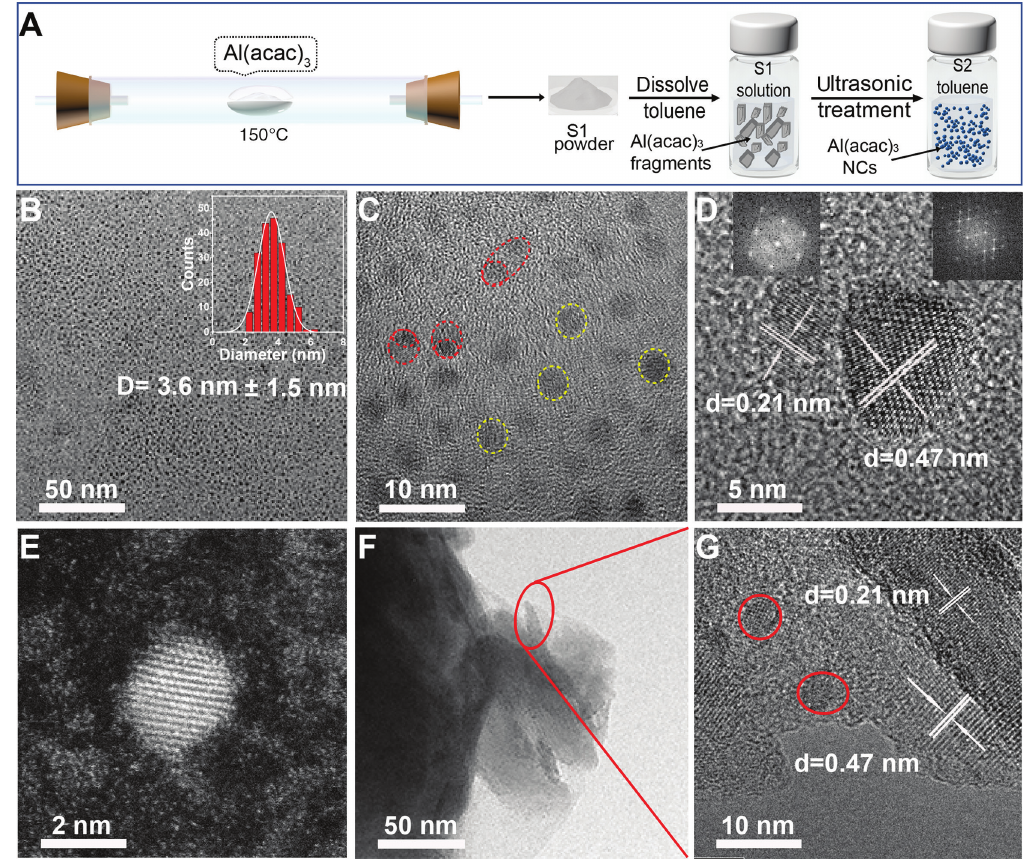
Figure 2: Schematic illustration of fabrication process and morphological characterization of S2. (A) Schematic illustration for the fabrication of Al(acac) NCs. (B) Low-resolution TEM image of monodispersed NCs of S2 and the 3 corresponding size distribution of the NCs (inset). (C) HRTEM image of S2. (D) Enlarged HRTEM image to show Janus hybrid structure with two types of lattice fringes ( d = 0.21 and 0.47 nm), and their FFT patterns are shown in inset. (E) The typical HAADF-STEM image of the single-type NCs with d = 0.21 nm. (F) TEM image of the existing nondisintegrated lamellar shape of S2 and corresponding enlarged HRTEM image